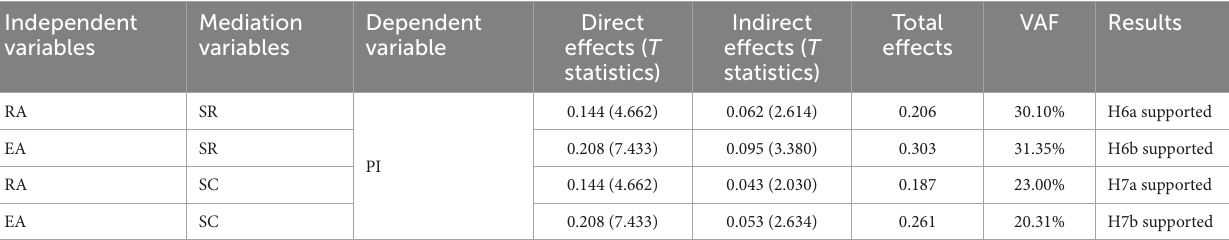
TABLE 6 Results of mediation effect